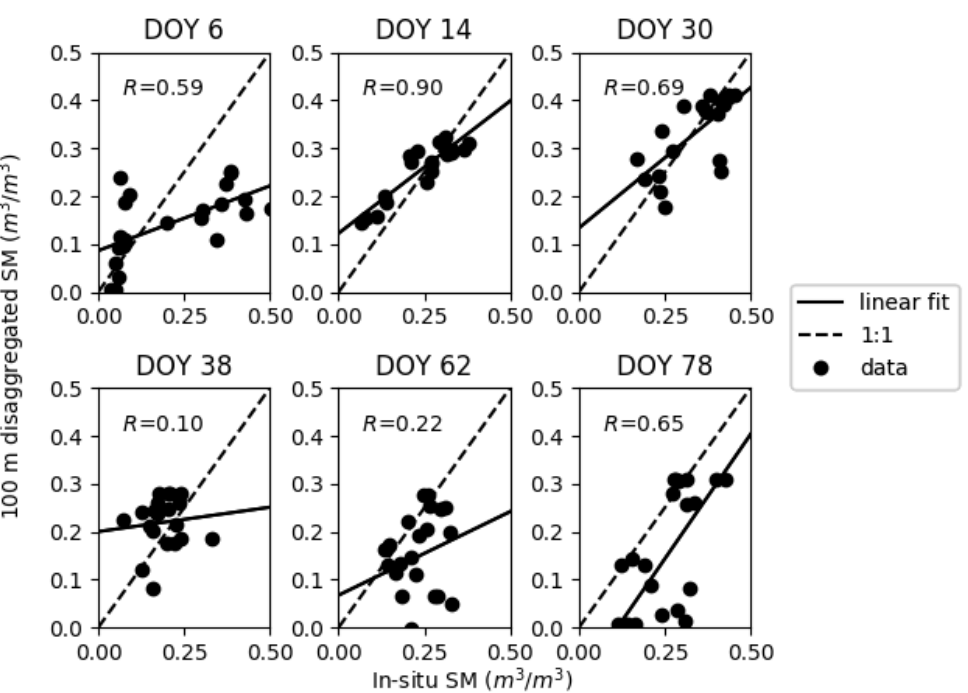
Figure 11. Graph plotting 100 m resolution disaggregated versus in-situ SM with the LR SM set to a fraction of the mean in-situ SM.